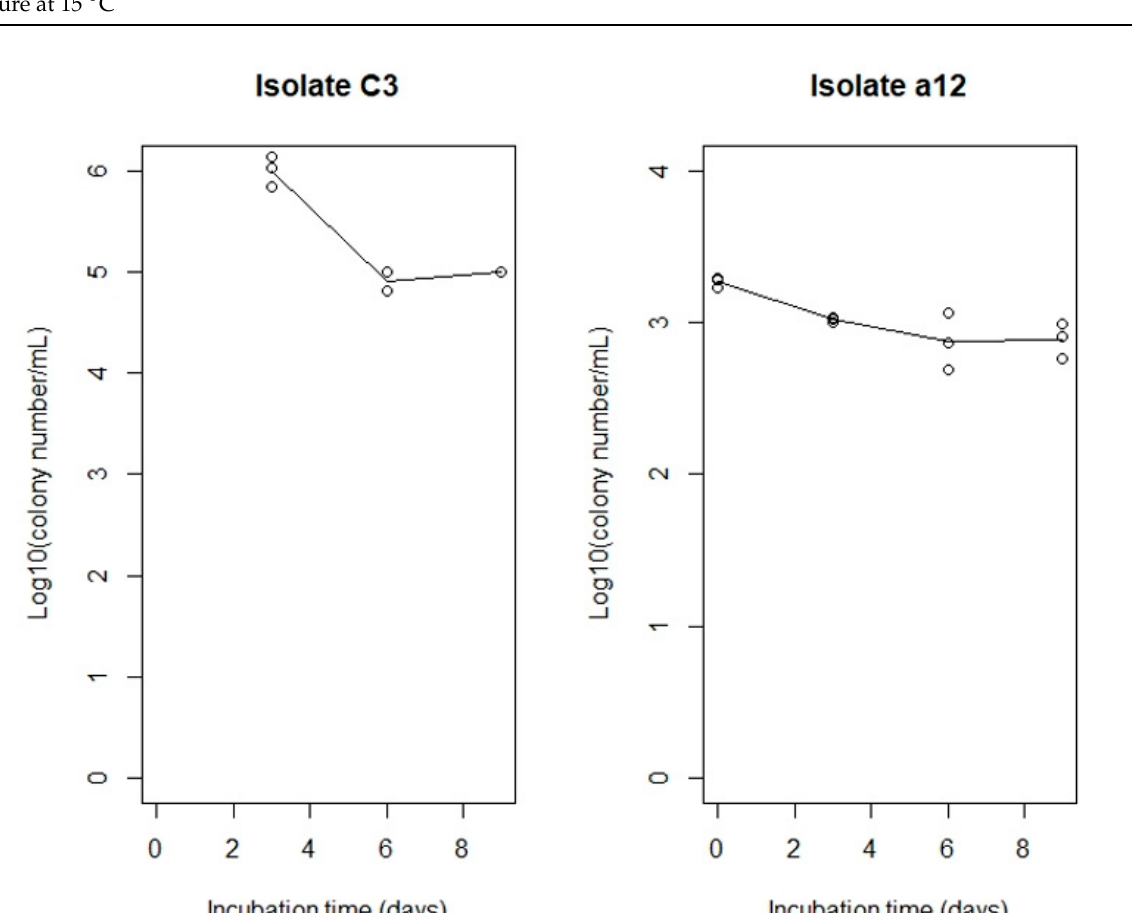
Figure 3. Growth of kuratsuki Bacillus isolates in TGY including 20% ethanol. The isolates C3 and a12 belonging to Groups 1 and 2, respectively, were statically cultured in TGY including 20% ethanol at 30 °C. Table 3. Number of isolates in each group.